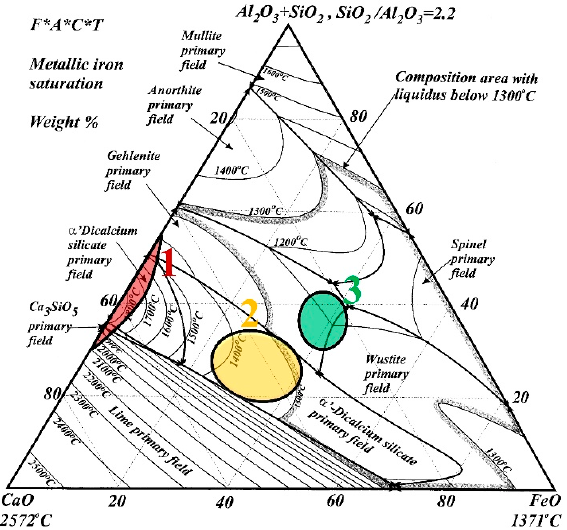
Figure 1. Samples identified on the CaO–FeO–SiO 2 –Al 2 O 3 system with a SiO 2 /Al 2 O 3 weight ratio